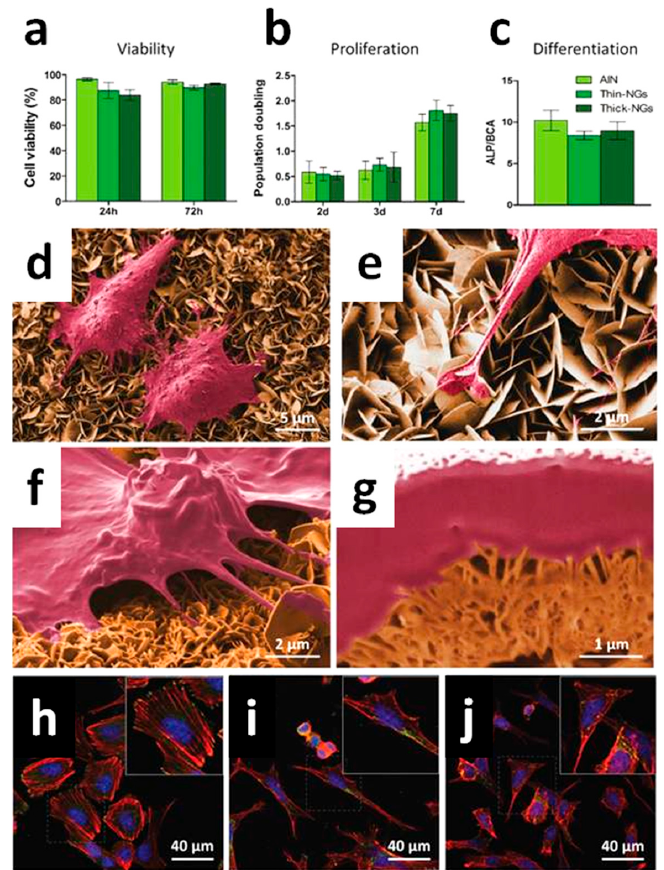
Figure 7. Biocompatibility of the thin and thick nanogenerators (NGs) and control aluminum nitride (AlN) for Saos-2 cells. ( a ) Viability was analyzed by the live/dead kit at 24 and 72 h of culture; ( b ) Proliferation by the Alamar Blue assay at 1, 2, 3, and 7 d; ( c ) Differentiation by a quantitative analysis of alkaline phosphatase activity (ALP) activity, a differentiation osteoblast marker, at 14 days of culture. No significant differences among materials were observed for any of those parameters ( χ 2 test and Kruskal–Wallis test); ( d , e ) Morphology and NG–cell interaction, assessed by scanning electron microscopy (SEM) and focused ion beam (FIB), showed that cells were firmly adhered to the nanosheets (NSs) ( d ) and emitted long projections that were anchored to the NSs ( e ); ( f , g ) Cells were completely adapted to the topography of the NSs ( f ), which were in direct contact with the plasma membrane ( g ); ( h – j ) Confocal laser scanning microscopy analysis after immunodetection of vinculin (focal contacts, green) and detection of actin (stress fibers, red) showed a high number of focal contacts at the end of long parallel bundles of actin filaments on cells grown on AlN, displaying a polygonal shape ( h ). The nuclei are stained in blue with DAPI dye. Shorter actin bundles and less focal contacts were present in cells grown on thin NGs ( i ) and thick NGs ( j ), which also displayed a more elongated, spindle-shape morphology (see the enlarged area). Scanning electron micrographs were false-colored for better visibility of the Saos-2 cells (magenta) and the nanogenerators (yellow). Modified with permission from reference [93]. Copyright (2017) John Wiley & Sons, Inc.